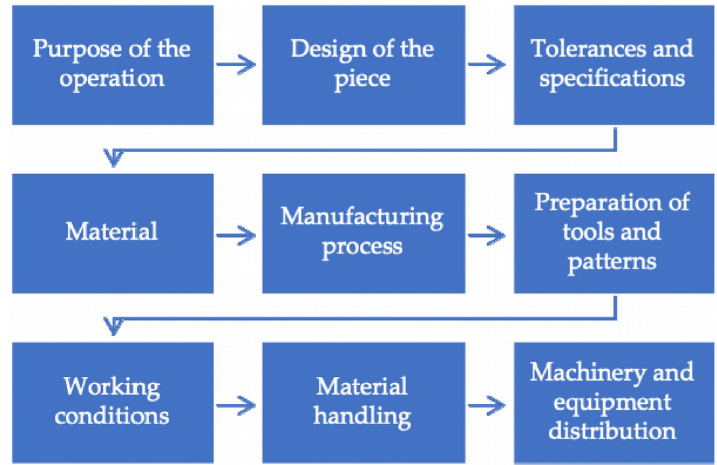
Figure 1. Basic approaches to operations analysis (Niebel & Freivalds, 2014)